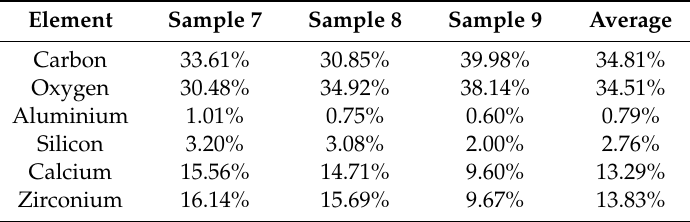
Table 3. Element analysis for the Bio-C Repair